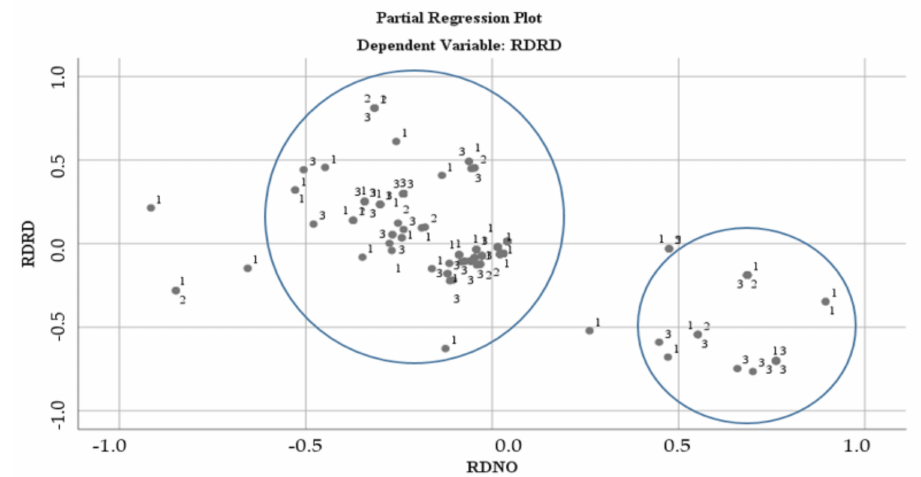
Figure 5. Regression analysis for